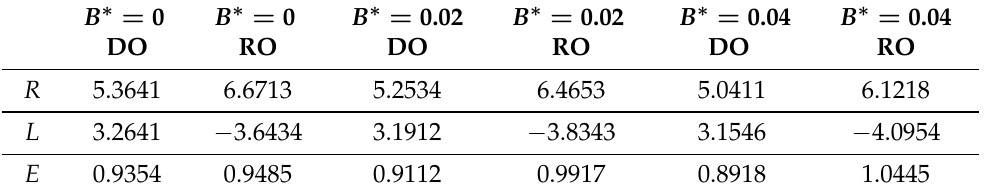
Table 6. Similar to Table 4, but the parameters are a = 0.2 and Q ∗ = 0. B ∗ =